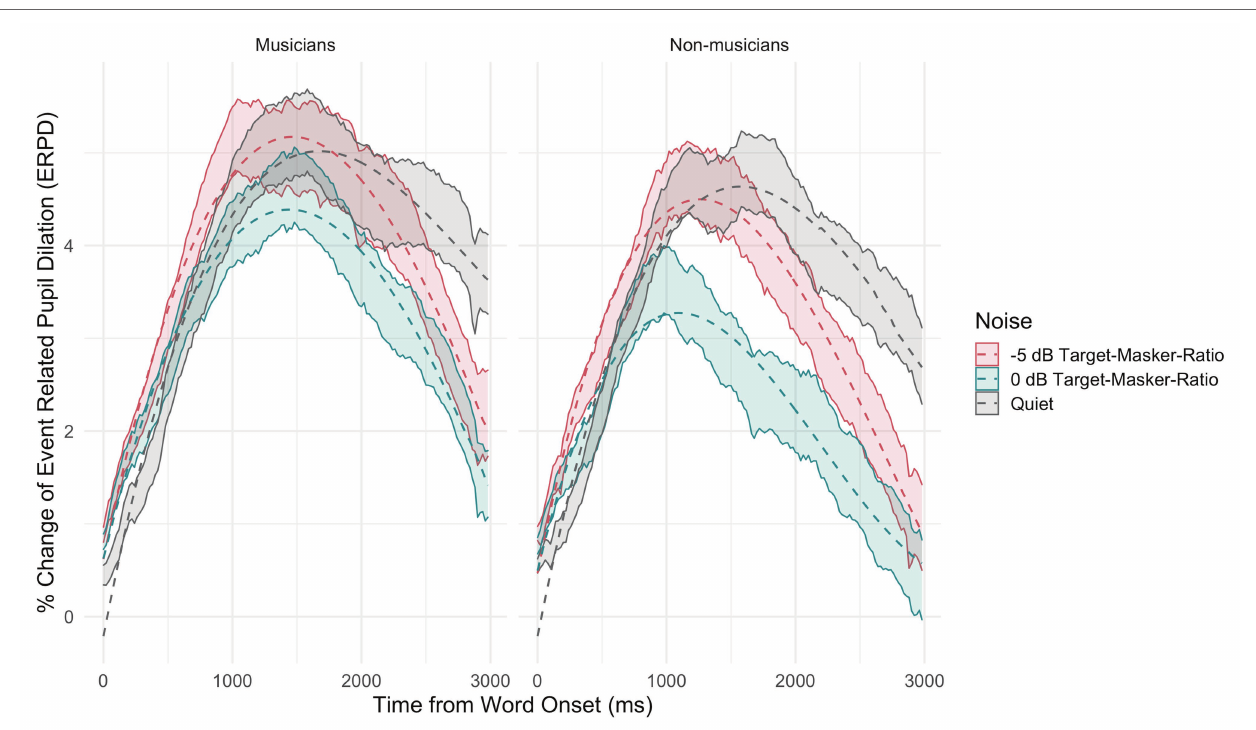
FIGURE 5 | Percentage of change in the observed pre-target baseline normalized event-related pupil dilation (ERPDs; transparent ribbon line with 95% CI) and as predicted by the model (solid lines), averaged across participants and items, shown for musicians (left panel) and non-musicians (right panel) across conditions (speech-in-quiet: gray, 0 dB TMR: turquoise, and − 5 dB TMR: